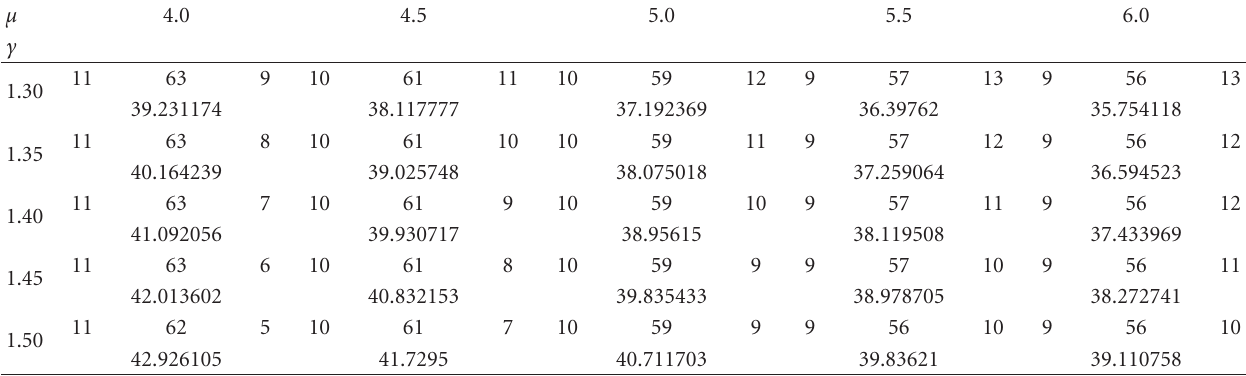
Table 5: Optimal values corresponding to various perishable rates and the replenishment rates ( λ = 14, β = 1 . 3, α = 4, p = 0 . 85).